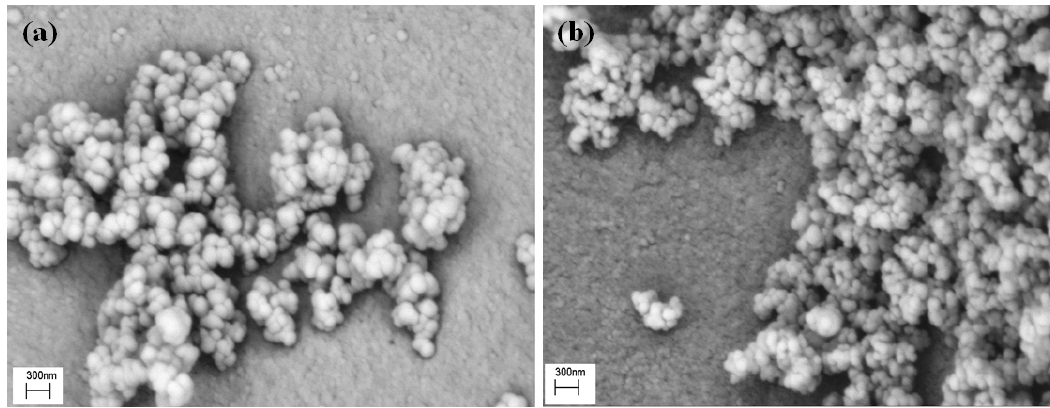
Fig. 2. The SEM images of a) pure TiO